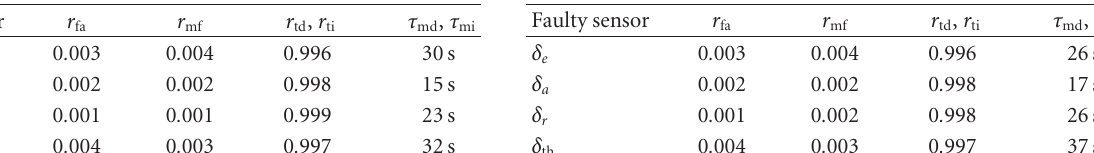
Table 10: UIKF Monte Carlo analysis with ν =